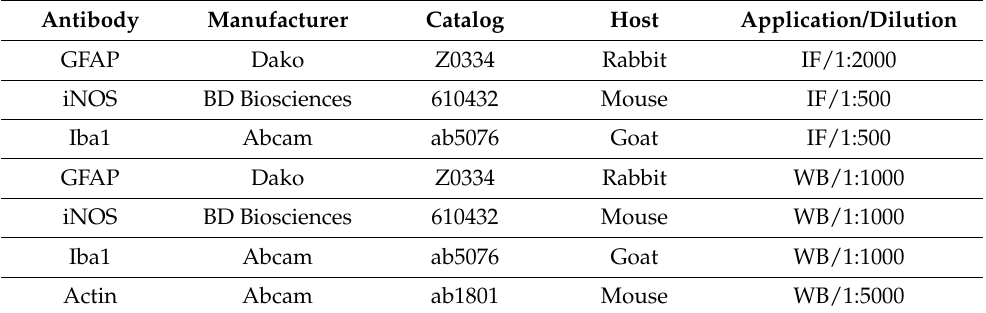
Table 1. Antibodies, sources and dilutions used in this